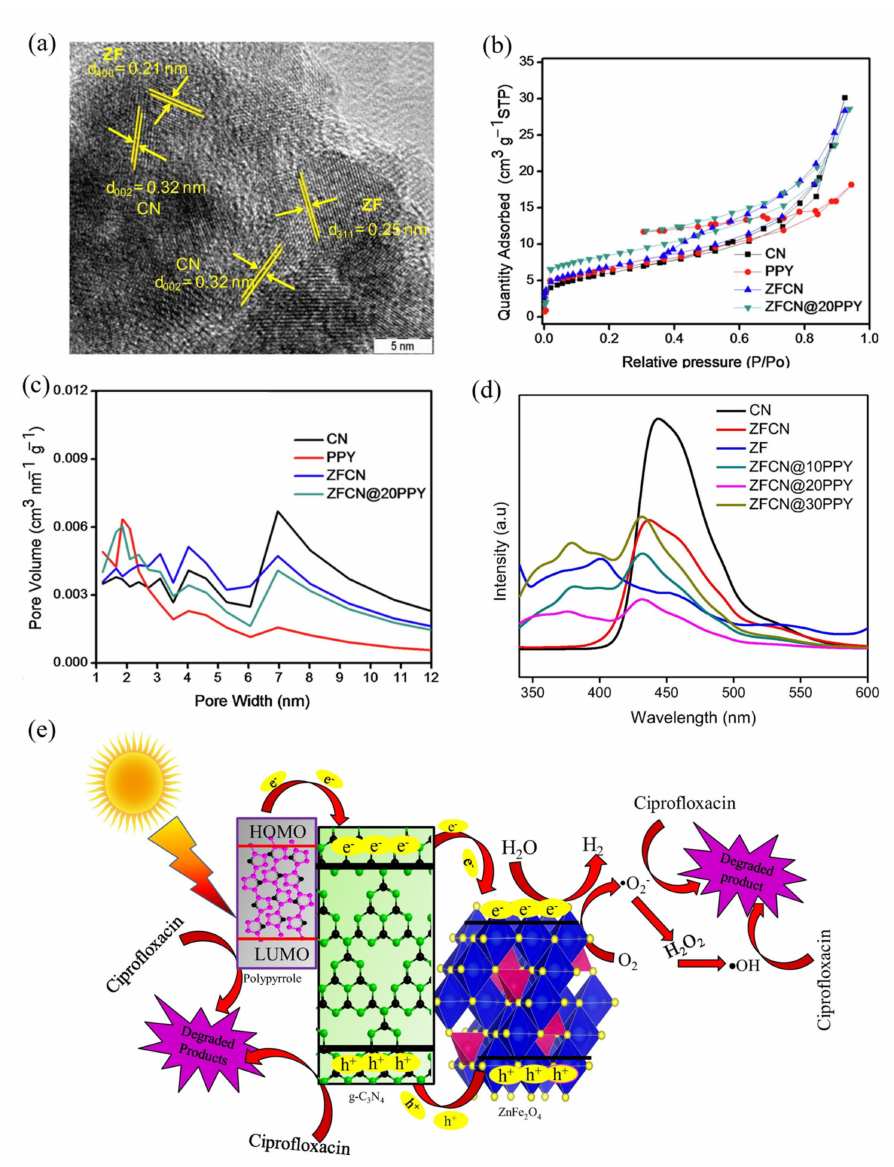
Figure 10. ( a ) High resolution transmission electron microscope images of ZFCN@20PPY; ( b ) N 2 adsorption-desorption isotherms obtained for PPY, CN, ZFCN, and ZFCN@20PPY; ( c ) pore size distribution; ( d ) photoluminescence (PL) spectroscopy; ( e ) a schematic representation of the reaction mechanism [101] (reprinted with permission from [101] Das et al.,